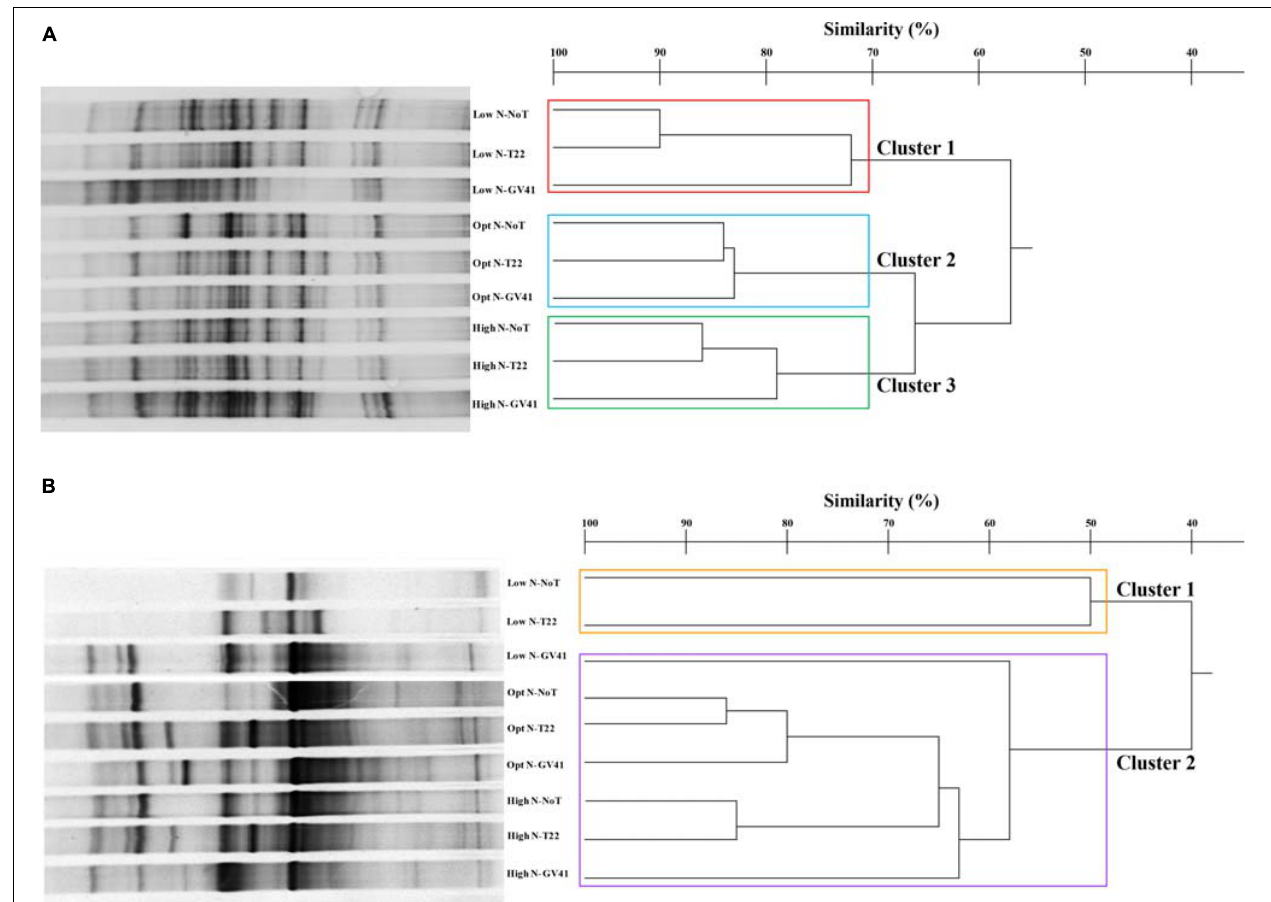
FIGURE 4 | DGGE profiles and dendrogram showing the degree of similarity (%) of the PCR-DGGE profiles of the prokaryotes (A) and eukaryotes (B) in rhizo-soil samples from lettuce. Low N, non-fertilized conditions (low N availability); Opt N, optimal N fertilization, amounting to 90 kg N ha − 1 ; High N, supraoptimal N fertilization, amounting to 180 kg N ha − 1 ; NoT, non-inoculated control; T22, T. harzianum strain T22; GV41, T. virens strain